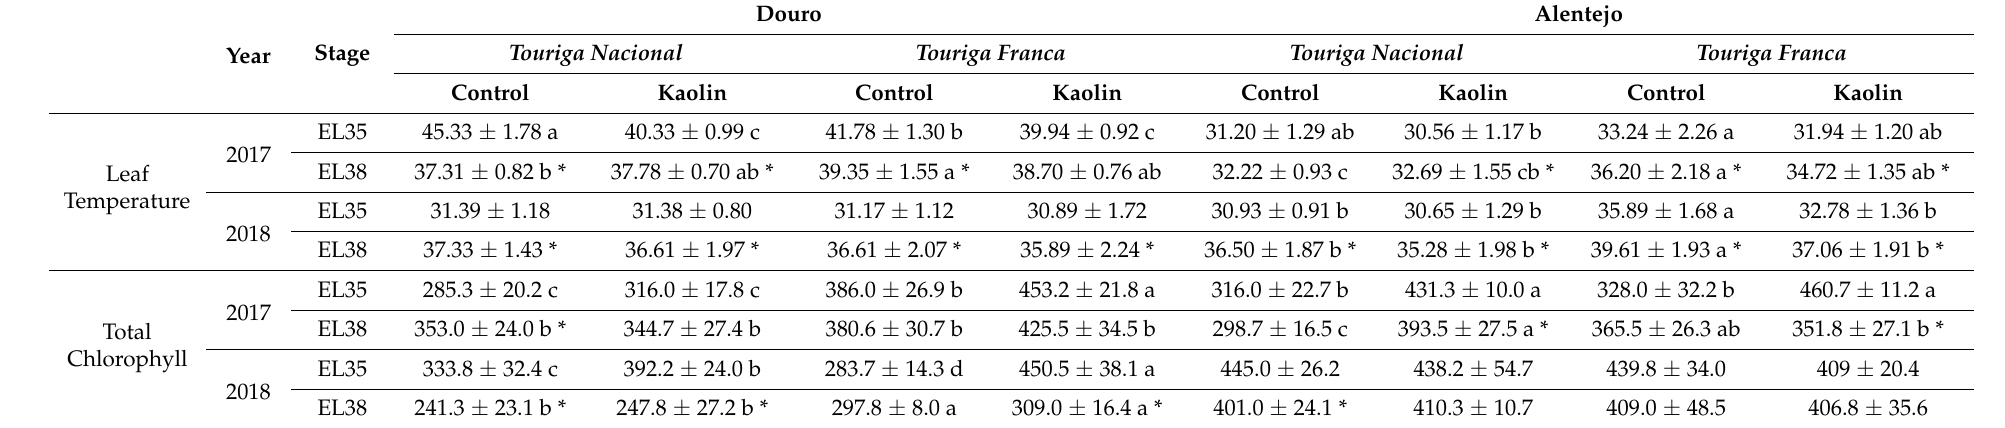
Table 2. Kaolin effects on leaf temperature ( ◦ C) and total content of chlorophyll (mg m − 2 ) in Touriga Naciona l and Touriga Franca varieties in two developmental stages (EL35 and EL 38), at the Douro and Alentejo trials, during 2017 and 2018 growing